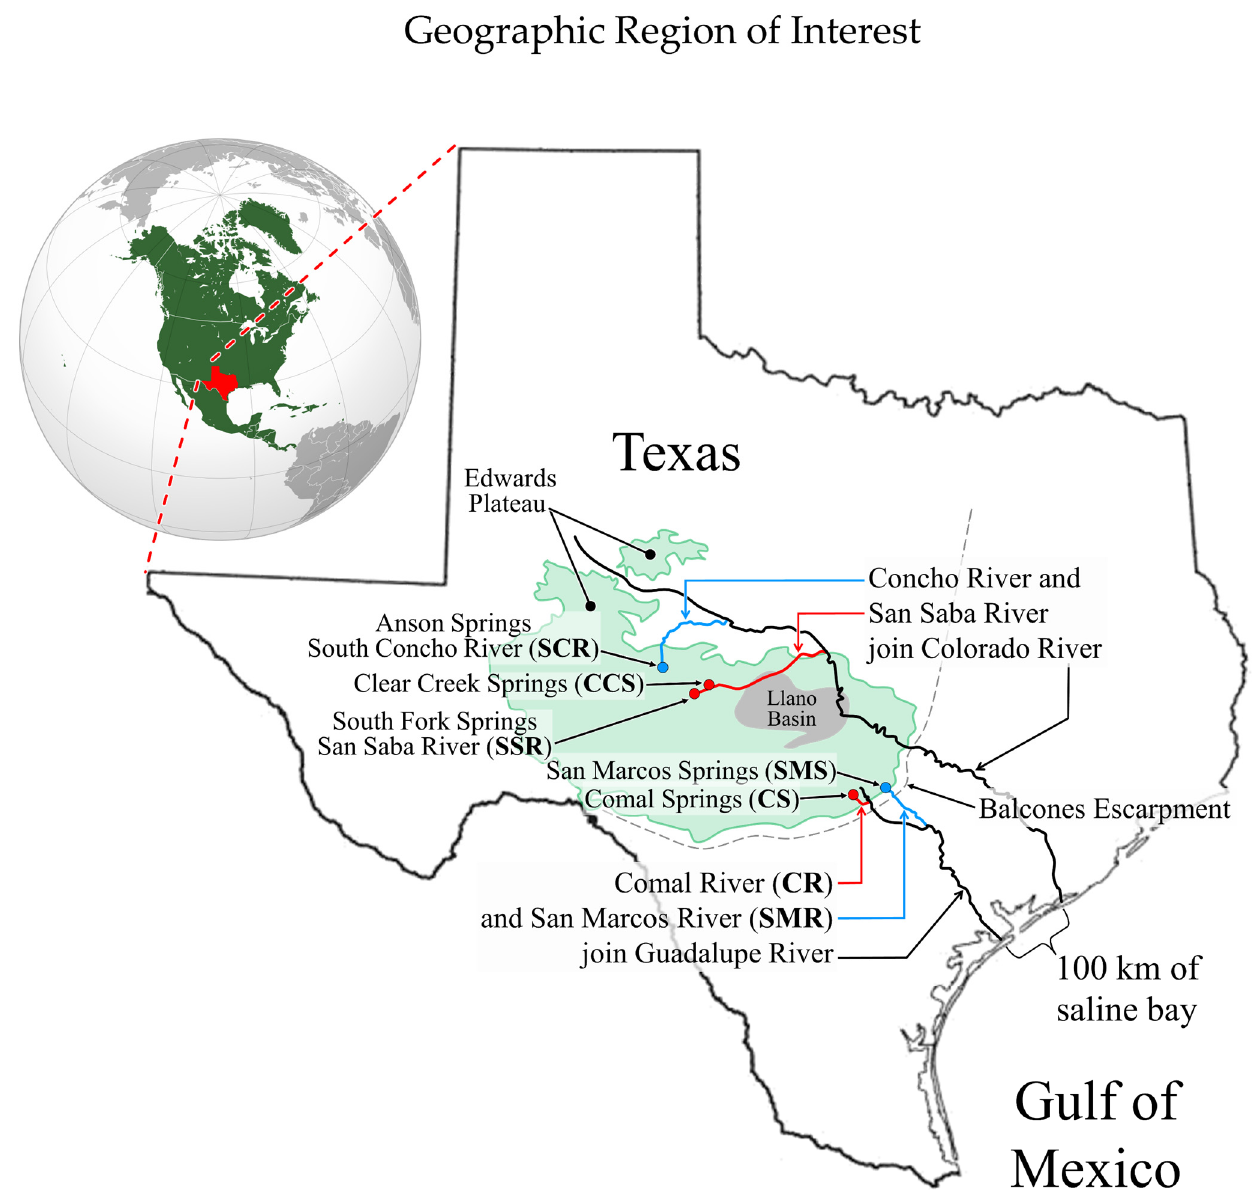
Figure 1. Map of Texas showing a rough outline of the Edwards Plateau with the springs of interest and their connecting streams. Map of NA from Wikimedia Commons.